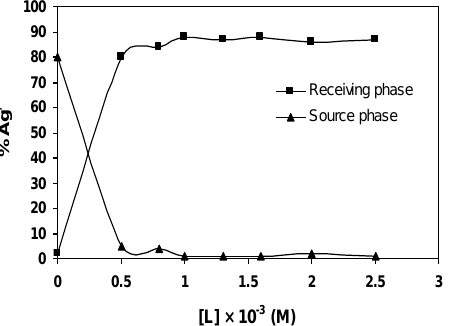
Figure 1: Effect of carrier concentration on Ag + cation transport. Experimental conditions: source phase, 10 ml of 3.0×10 -4 M Ag + cation and 3.0×10 -3 M picric acid at pH 4; liquid membrane phase, 50 ml of varying concentration of carrier in DCM; receiving phase, 5 ml of 1.0×10 -3 M S O 32- at pH 3; time of transport, 4 hours. 2